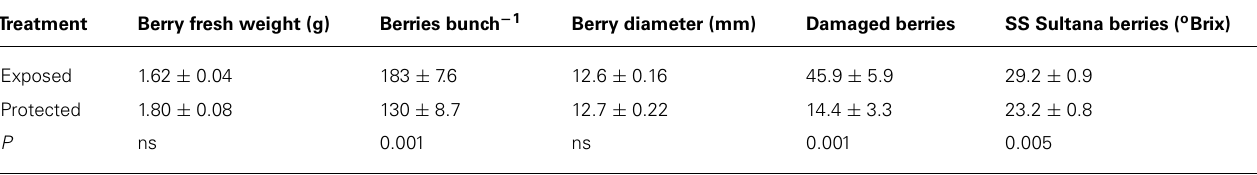
Table 2 | Berry attributes at harvest (Mean ± SE, N = 36) of Semillon bunches from vines grown in exposed conditions and compared with protected bunches covered by shade cloth during the 2008/09 growing season.